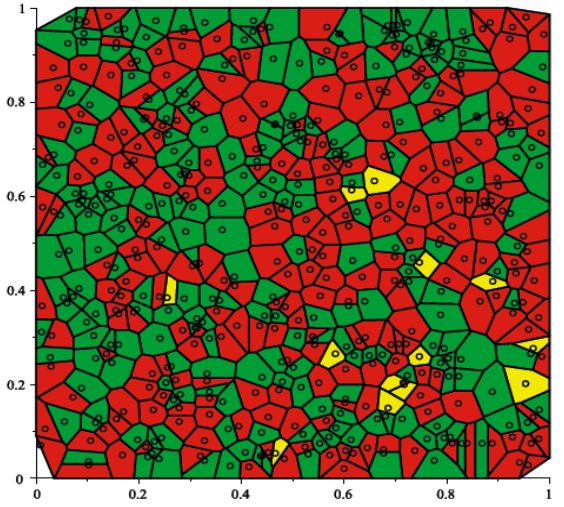
Figure 1. Voronoi diagram for randomly selected plot: 1983rd year cycle of measurement (mean age, 71.05 years); red — Scots pine trees; green — Norway spruce trees; yellow — birch trees; circles — tree position.